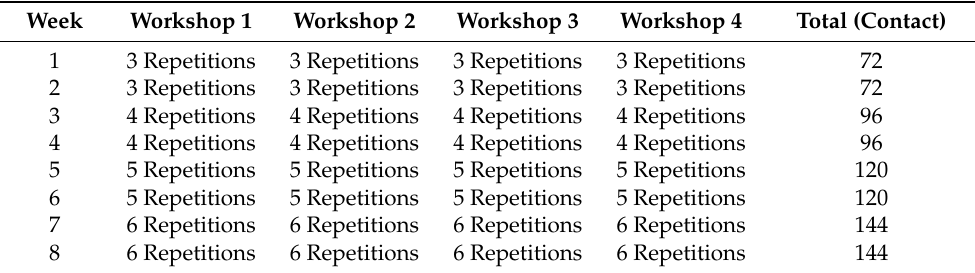
Figure 1. Exercise used in loaded combined plyometric and short sprint training group. For the EG, each LPaSS workshop began with plyometric exercises (hurdle jumps, lateral hurdle jumps, bouncy strides, and drop jumps) and finished with short sprints. Details are given in Table 2. The EG executed all workshops with a weighted vest (8% body mass) [18,19]. Plyometric training design was based on from Bedoya et al. [30] and the sprint training protocol was based on recommendations for CoD ability [31,32]. Table 2. Plyometric components in the program of the experimental